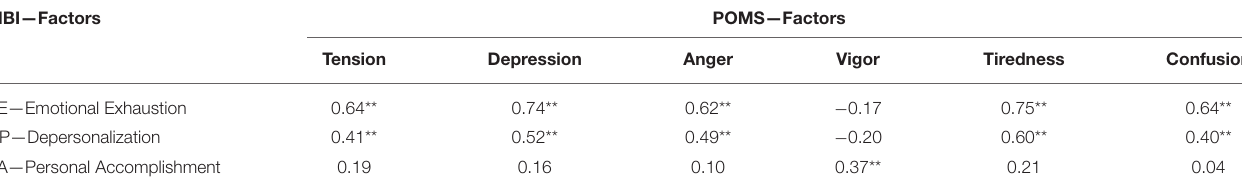
TABLE 5 | Person correlations among the MBI-HSS and POMS factors in healthcare professionals’ group. MBI—Factors